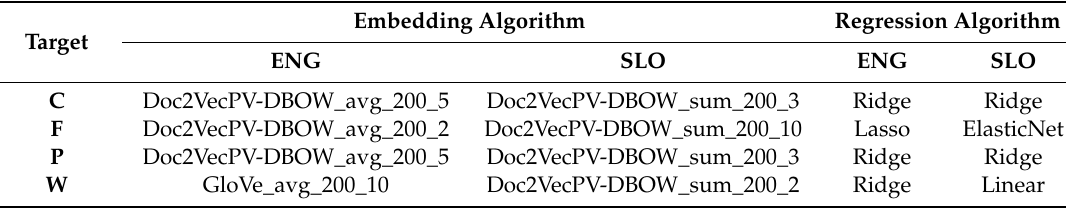
Embedding and regression algorithms which yielded highest accuracies for each macronutrient prediction on the whole dataset (without clustering). Target: C—Carbohydrates, F—Fat, P—Protein, W—Water.